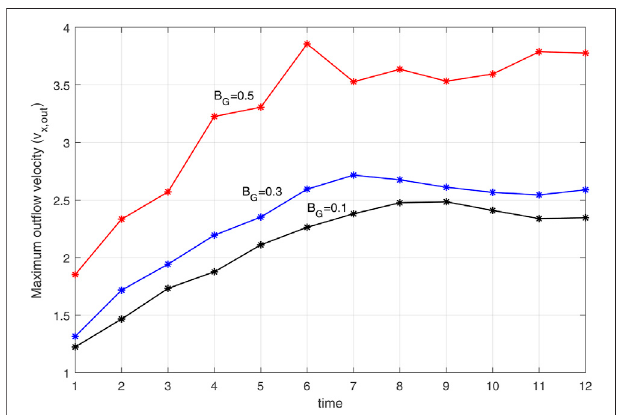
FIGURE 8 | Time variation of maximum out fl ow velocity with uniform guide fi eld.